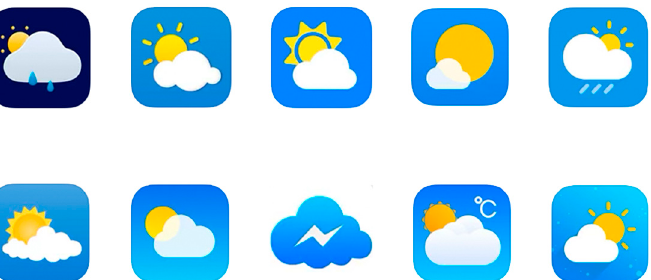
Figure 1. When searching for weather apps in the Apple Store, you can see a strong similarity in the icon design of these apps.